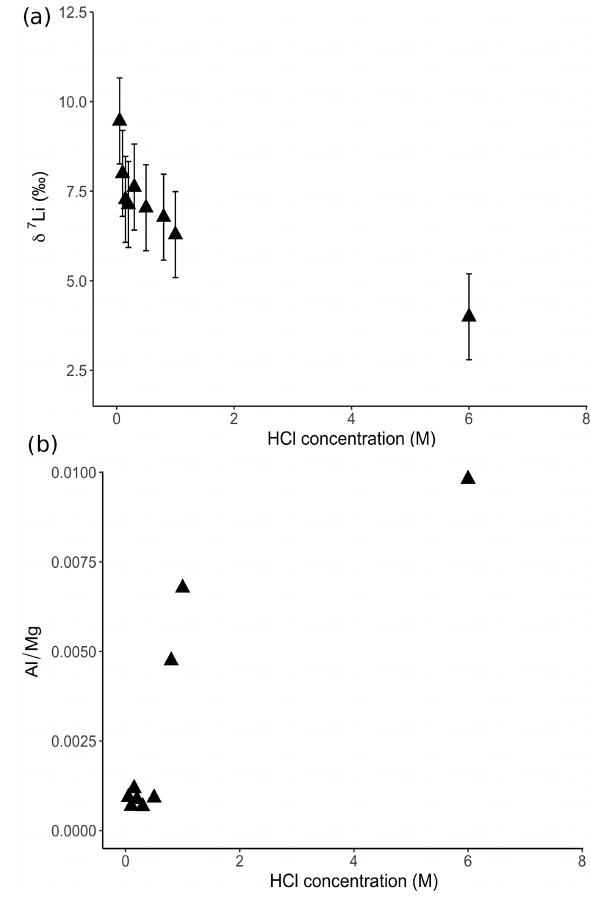
Figure 5. (a) Lithium isotope compositions and (b) Al / Mg ratios of solutions from dolostone leaching, as a function of their HCl con- centration. Decreasing δ 7 Li values with increasing HCl concentra- tion suggest a release of isotopically light Li from clay minerals, which is supported by the increase in the Al / Mg ratios. Error bars are within the symbol size, if not